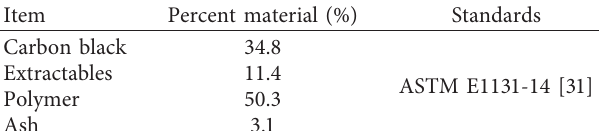
Table 3: Compounds of crumb rubber.